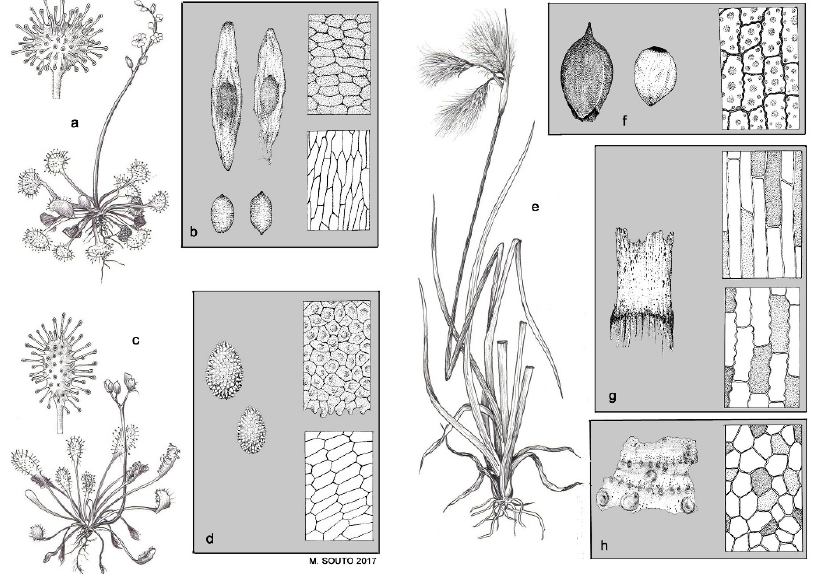
Figure 2. Fresh plants and corresponding macrofossils: Drosera rotundifolia ( a ) habit, ( b ) seeds; Drosera intermedia ( c ) habit, ( d ) seeds; Eriophorum sp ( e ) habit, ( f ) achenes, ( g ) remains of stems, ( h ) remains of rhizomes (Souto, 2018) [38].